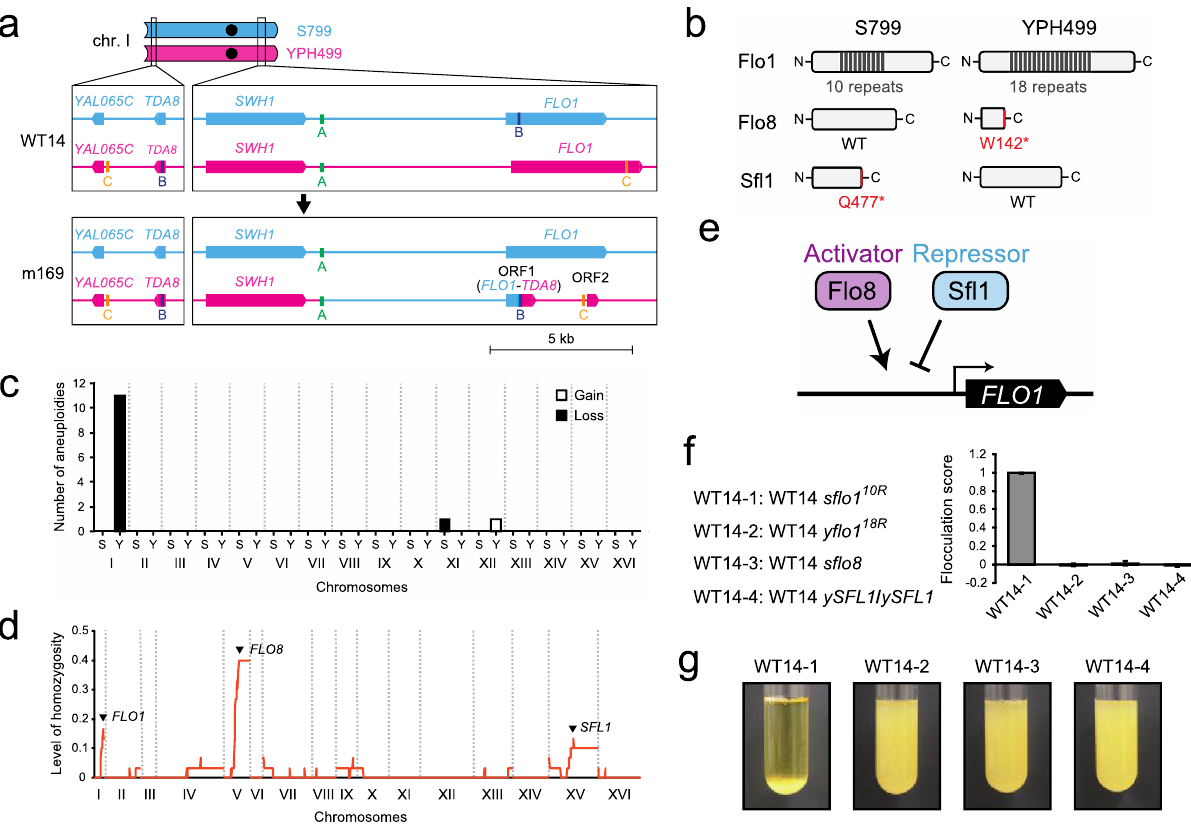
Figure 3. Comparative analysis of genomes of non-flocculent TAQed mutants. ( a ) Complex gene conversions at subtelomeric regions in non-flocculent m169. Recombinations of homologous sequences A (green), B (navy blue), and C (yellow) lead to the depletion of the YPH499-derived FLO1 gene and generates the two de novo ORFs. ORF1 is a fusion gene of FLO1 and TDA8 and ORF2 is the coding region of the FLO1 3’-terminus. ( b ) Natural variation in Flo1, Flo8, and Sfl1 proteins between parental strains. W142 in YPH499-derived Flo8 and Q477 in S799-derived Sfl1 were replaced by stop codons. ( c ) Number of aneuploidies within 30 non-flocculent TAQed mutants (S, S799; Y, YPH499). White bars show chromosomal gain and black bars show a chromosomal loss. ( d ) Level of homozygosity across the genome within 30 non-flocculent TAQed mutants, calculated as the ratio of homozygosity/heterozygosity in 10 kb windows. ( e ) Schematic diagram of the regulatory network of the FLO1 gene. Flo8 activator and Sfl1 repressor have an antagonistic role in regulating the gene expression by binding the common promoter element. ( f ) Flocculation scores of WT14-1 ( sflo1 / yFLO1 ), WT14-2 ( sFLO1 / yflo1 ), WT14-3 ( sflo8 / yflo8 ), and WT14-4 ( ySFL1 / ySFL1 ). Error bars represent standard deviation ( n = 3). ( g ) Flocculation behaviors of WT14-1 ( sflo1 / yFLO1 ), WT14-2 ( sFLO1 / yflo1 ), WT14-3 ( sflo8 / yflo8 ), and WT14-4 ( ySFL1 / ySFL1